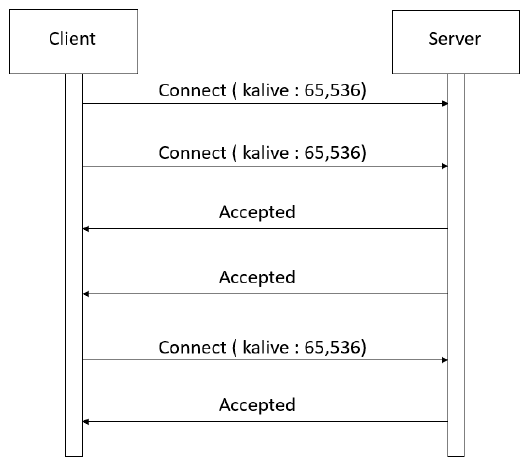
Figure 9. SlowITe Figure 9. SlowITe attack.